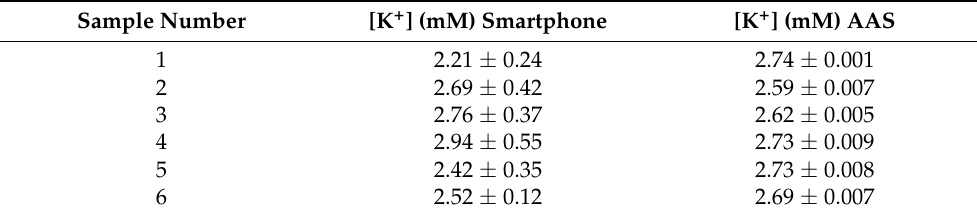
Table 2. Comparison of [K + ] of lyophilized blood plasma samples obtained by smartphone device and AAS.